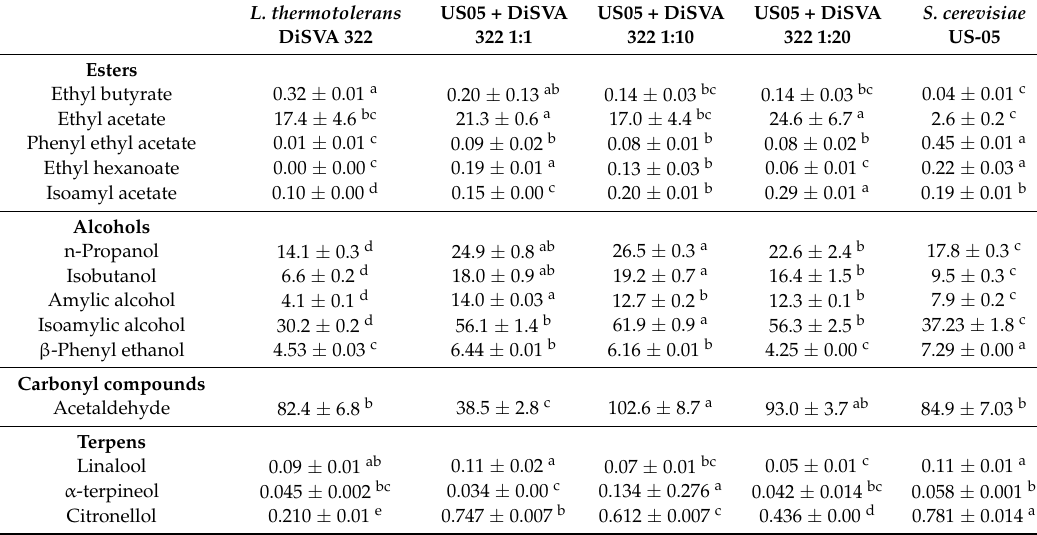
Table 3. The main by-products and volatile compounds in the beers produced by L. thermotolerans in the pure and mixed fermentations (mg/L).